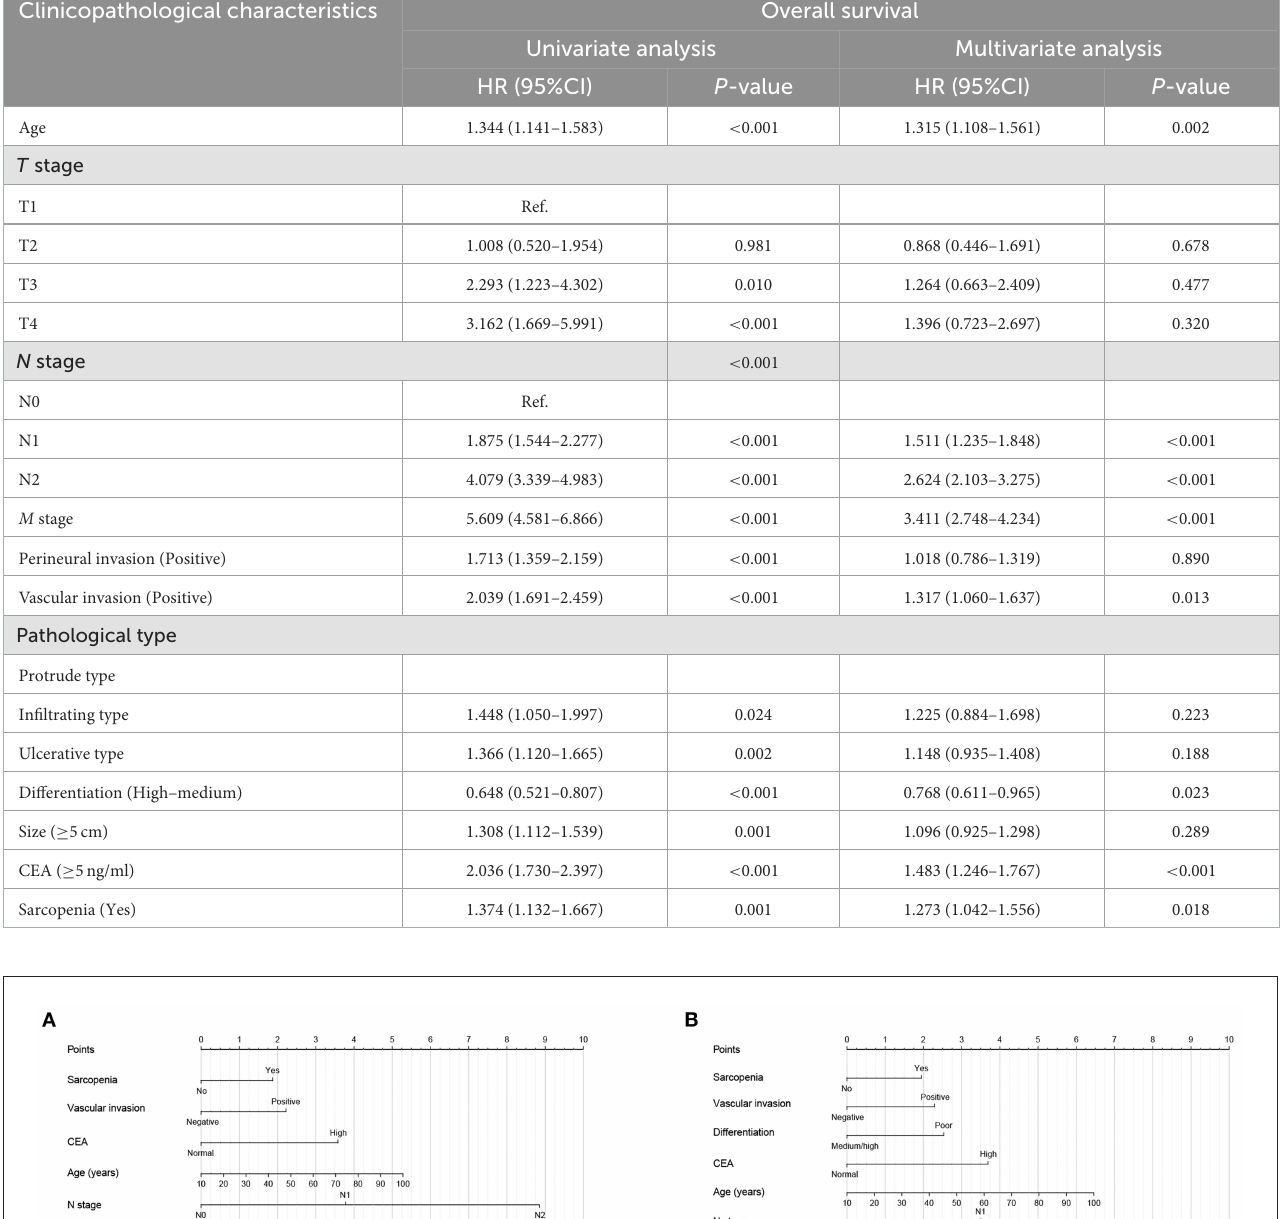
TABLE 3 Univariate and multivariate Cox regression analysis of clinicopathological characteristics associated with overall survival in CRC patients.